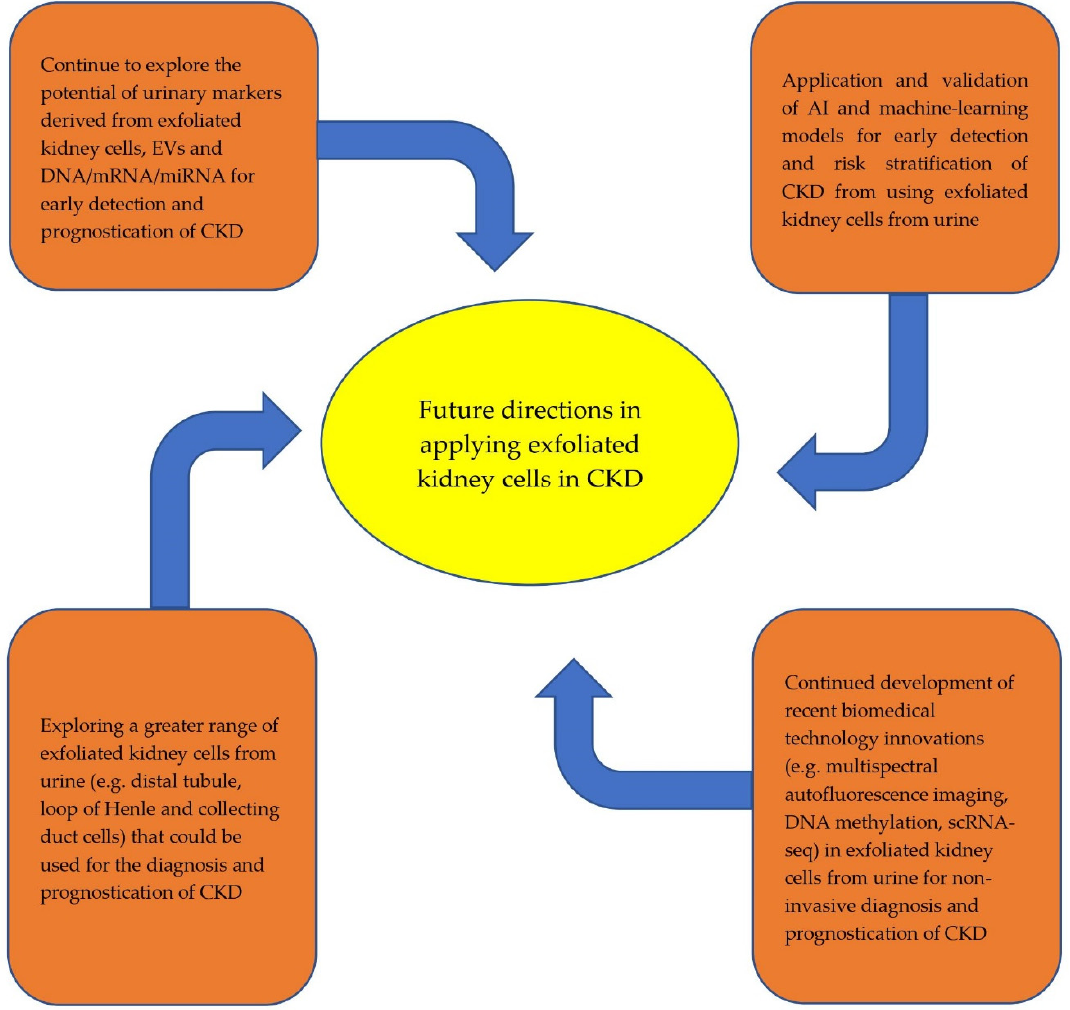
Figure 1. Future directions in the application of exfoliated kidney cells from urine for early diagnosis and prognostication of CKD.